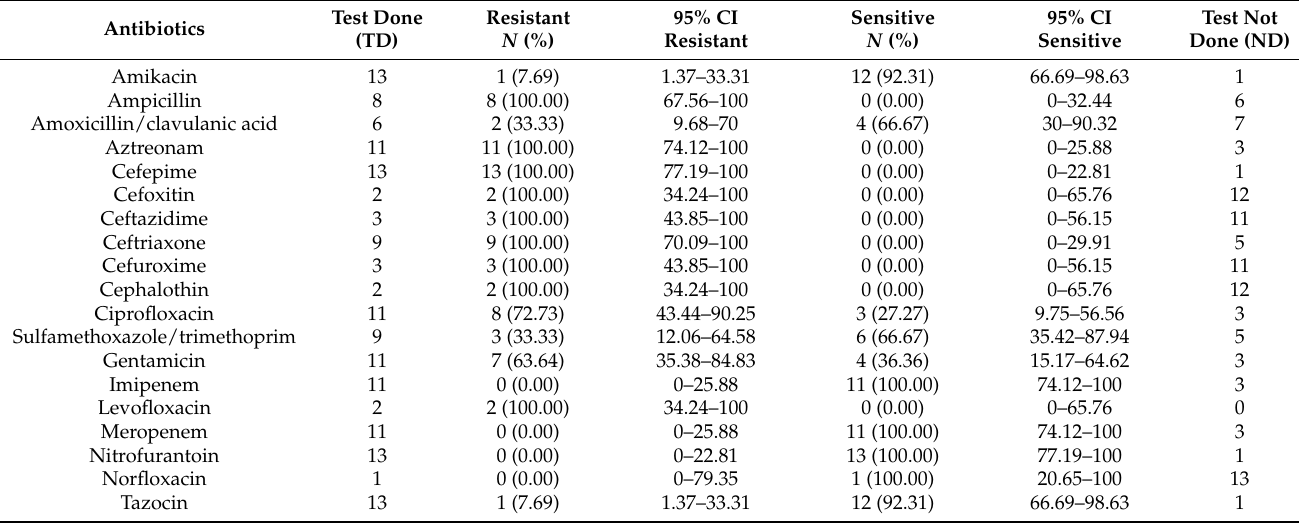
Table legend text. TD = respective antibiotic tested against ESBL-positive E. coli ; ND = respective antibiotic was not tested against ESBL-positive E. coli .